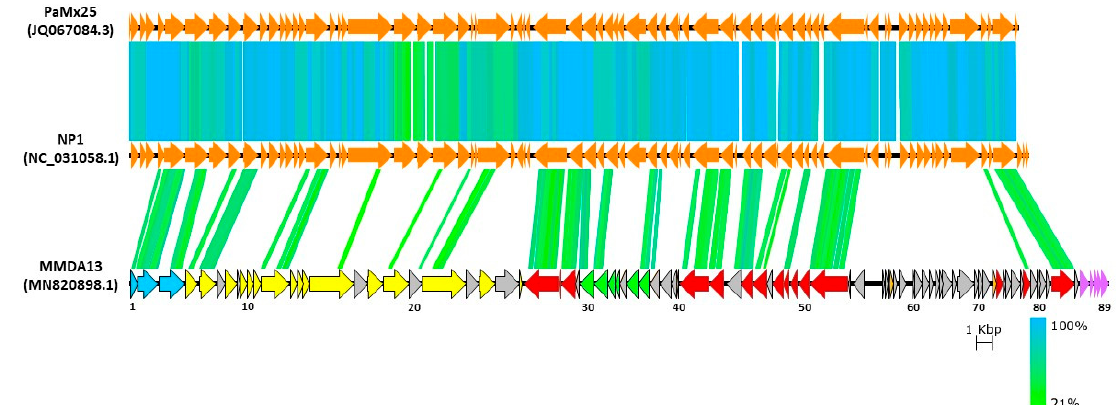
Figure 6. Comparison of vB_StuS_MMDA13 with the members of the Nipunavirus genus NP1 and PaMx25. ORFs are depicted according to the colouring scheme of Figure 3. Numbers indicate ORFs in the vB_StuS_MMDA13 genome. Homologues regions detected by a TBLASTX search are connected by segments coloured on the basis of amino acid identity. Homologues regions derived by segments <70 amino acids are not reported for clarity.